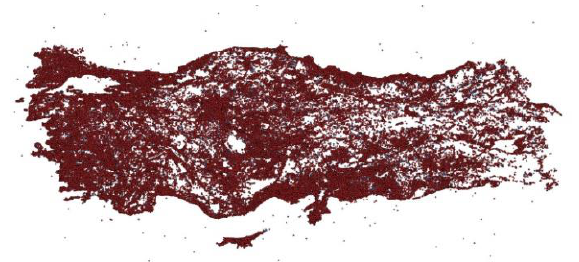
Figure 8. 2016 Year CORS-TR System Usage Map